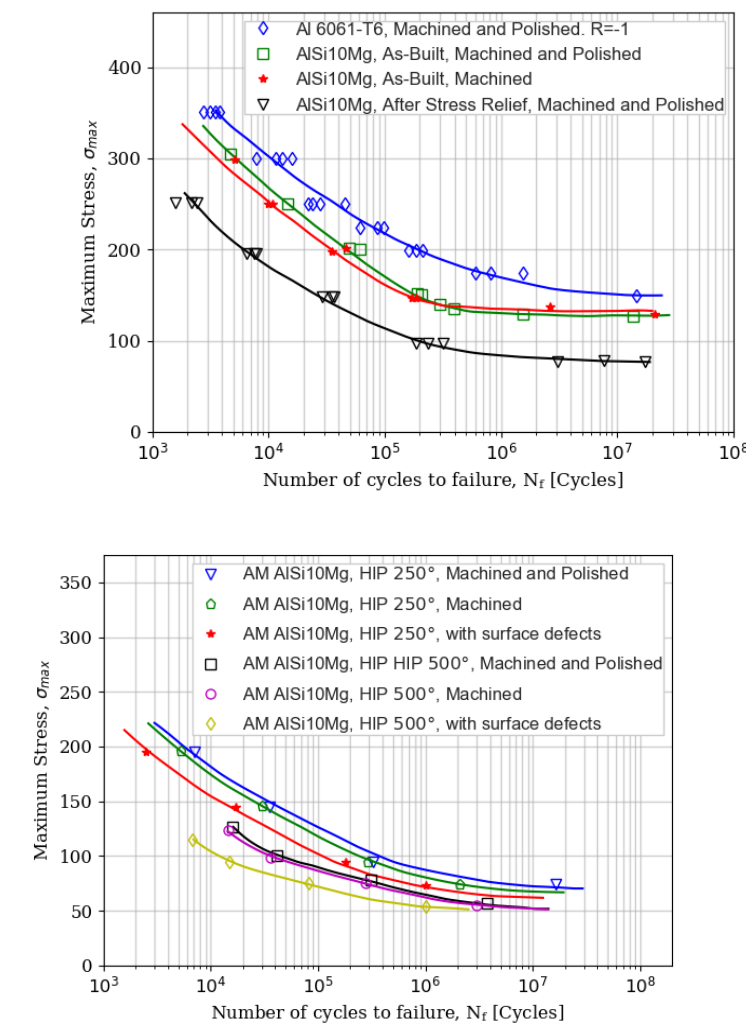
Figure 41: Fatigue of SLM AlSi10Mg and 6061-T6 in (a) as built and machined condition, and (b) after stress relieving and HIP’ing